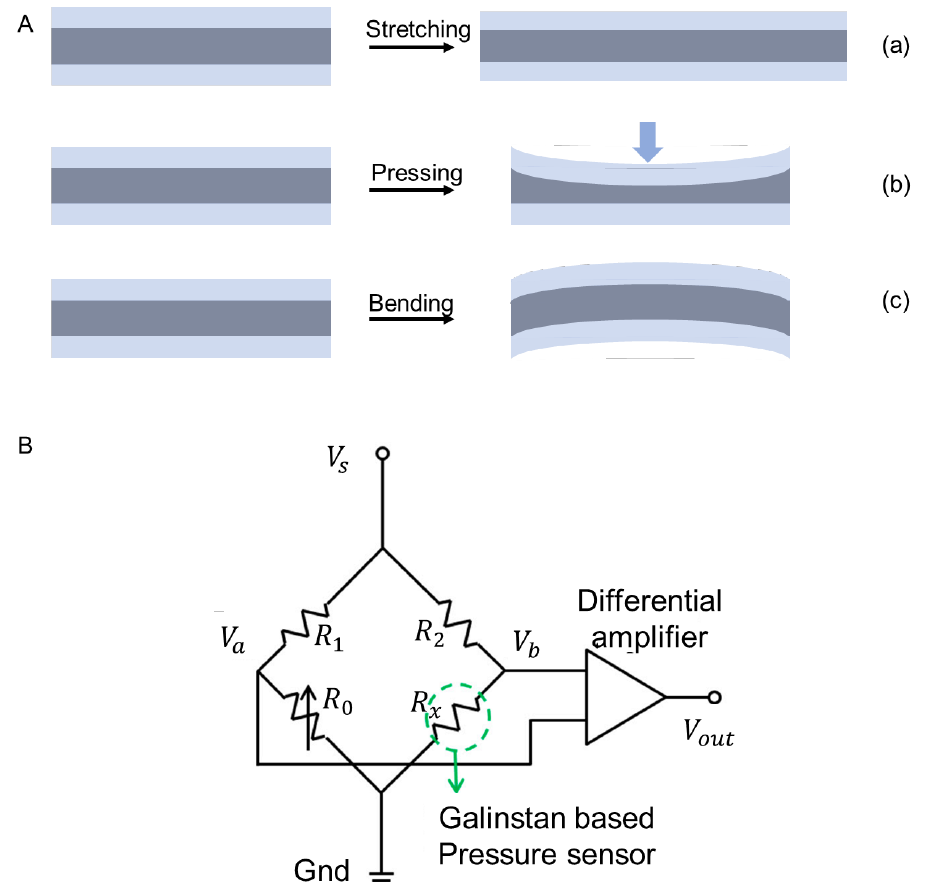
Figure 7. Working principle of resistive sensor. ( A ) Deformation of liquid metal under external force. Blue represents soft substrate and gray represents liquid metal: ( a ) Stretching; ( b ) Pressing; ( c ) Bending. ( B ) Wheatstone bridge to detect the resistance of the liquid-metal pressure sensor, reproduced with permission from [95].